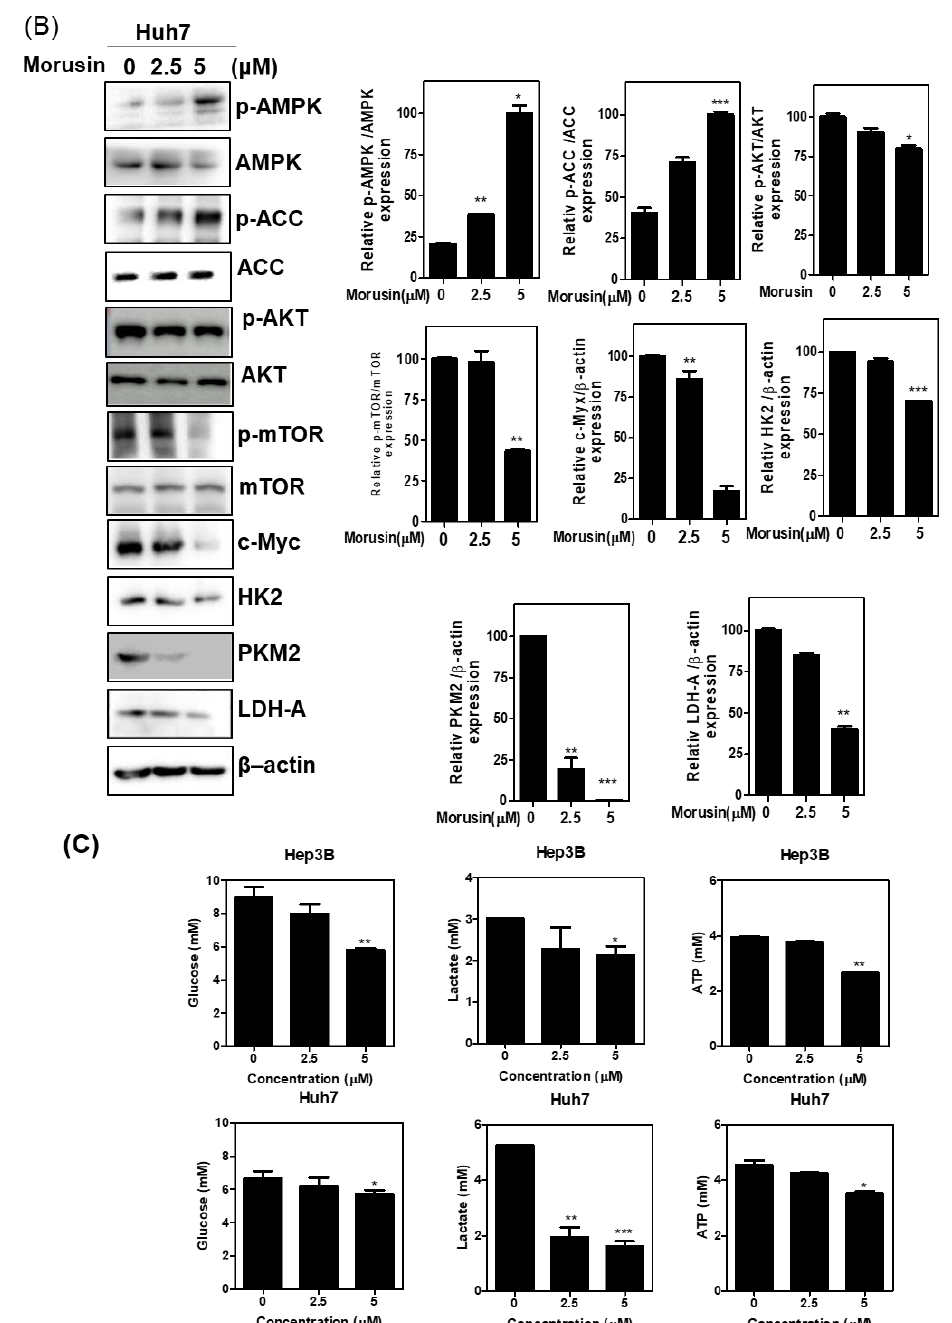
Figure 3. Effect of Morusin on glycolysis related proteins in Hep3B ( A ) and Huh7 ( B ) cells. Huh7 and Hep3B cells were treated with Morusin (2.5, 5 μM) for 24 h. Cell extracts were prepared and subjected to Western blotting with the antibodies of p- AMPK, AMPK, p-AKT, AKT ACC p-ACC, ACC, p-mTOR, mTOR, c-Myc, HK2, PKM2, LDH-A, and β-actin. ( C ) Glucose, lactate, and ATP in conditioned medium were measured using colorimetric assay kit. Data represent means ± SD. *, P < 0.05, **, P < 0.01, ***, P < 0.001 vs. untreated control ( n = 3).